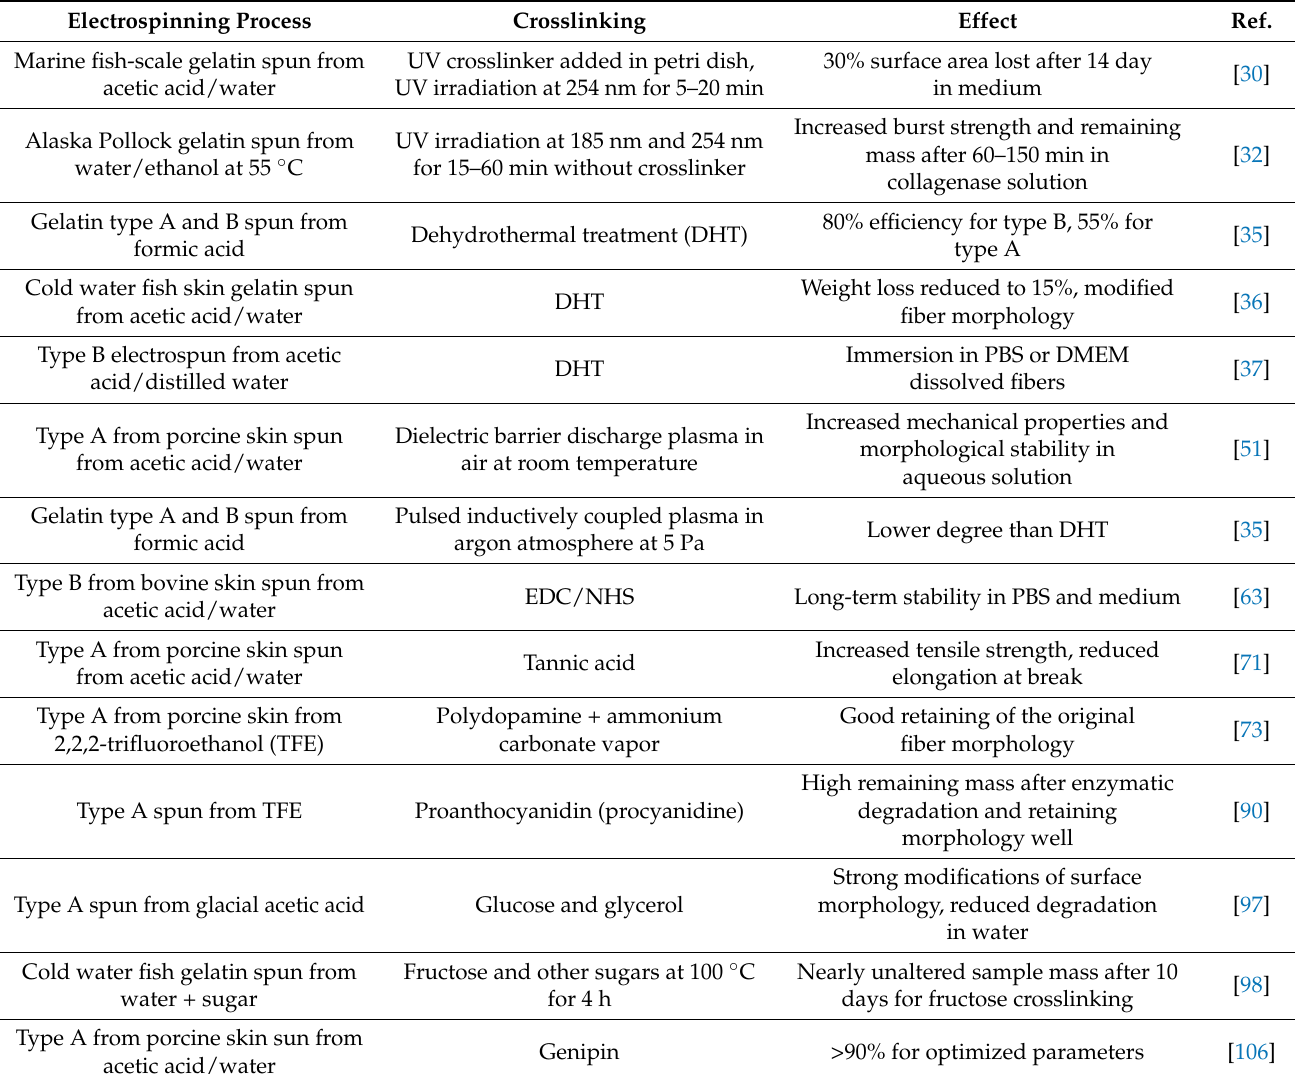
Table 1. Effect of crosslinking for different crosslinking techniques after